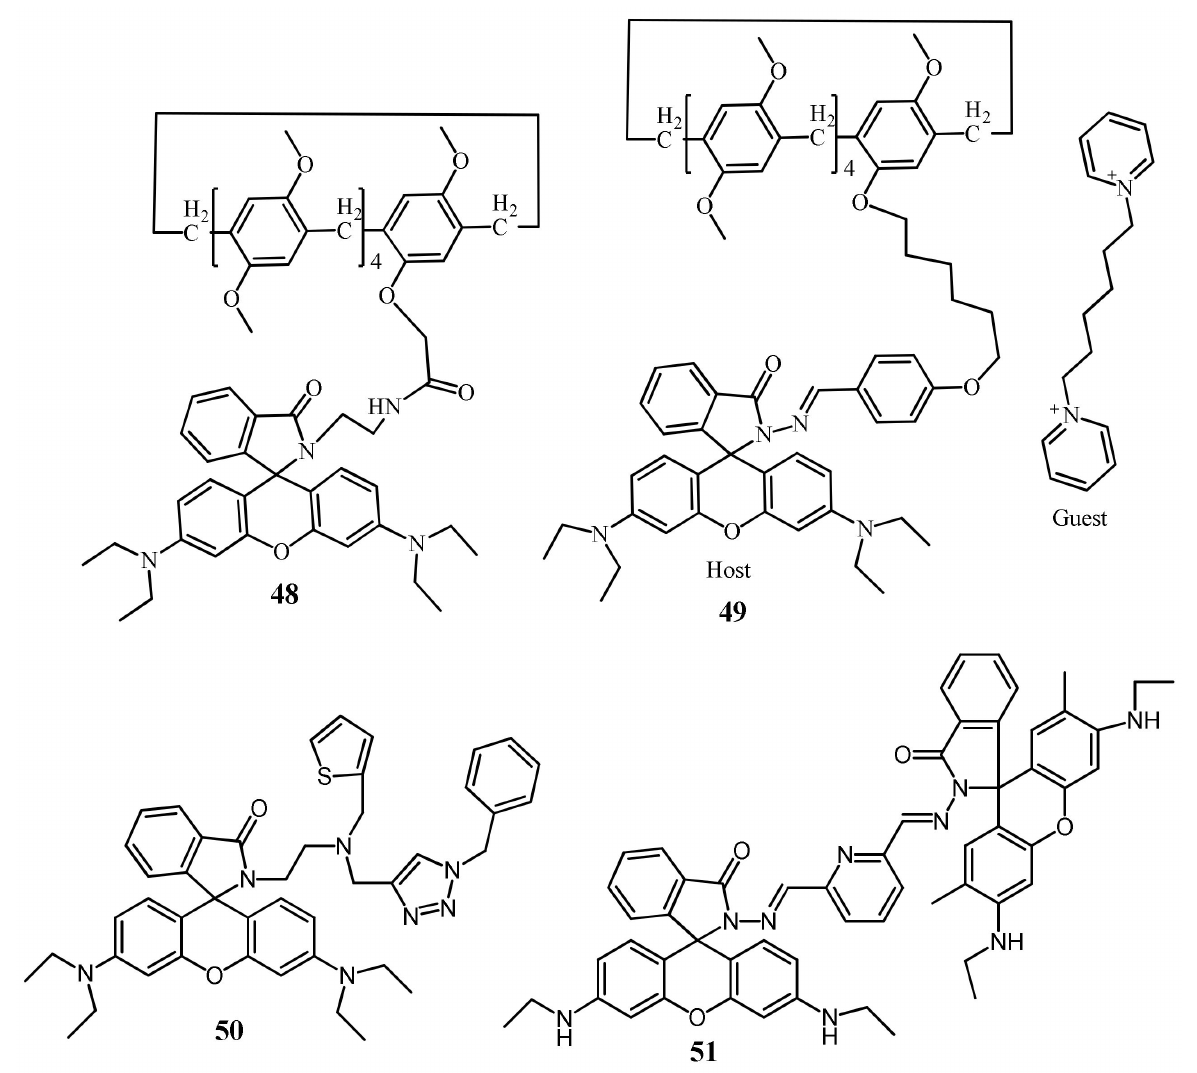
Figure 17. Molecular structures of the sensors 48 to 51